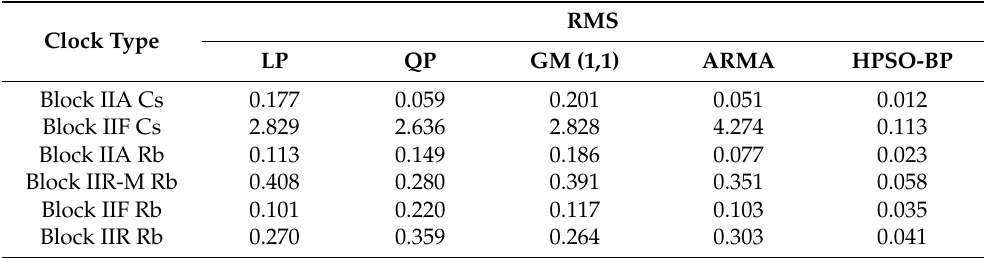
Figure 5. Prediction precision of each satellite by the five models on 30 January 2019 and 13 September 2020 (Satellite 24 is not shown in the figure. Specific results for satellite 24 are shown in Tables 8 and 9). Table 8. Statistics of average prediction results of five models for six different clock types on 30 January 2019 (Unit: ns).